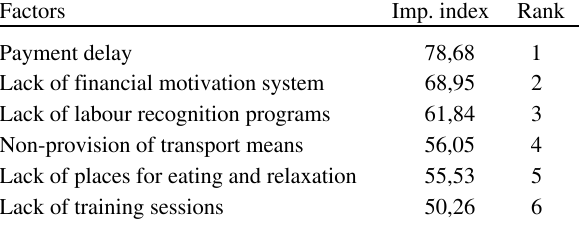
Table 3. Ranking factors under motivational